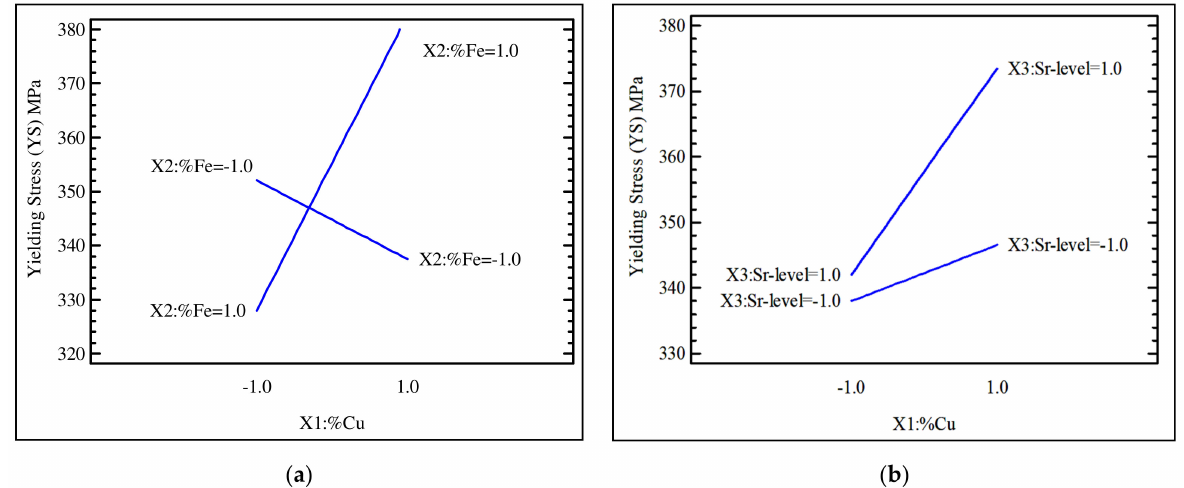
Figure 4. ( a ) Interactive effect of %Cu (X 1 ) and %Fe (X 2 ); ( b ) interactive effect of %Cu (X 1 ) and Sr-level (X 3 ) on the yield stress values (YS in MPa).